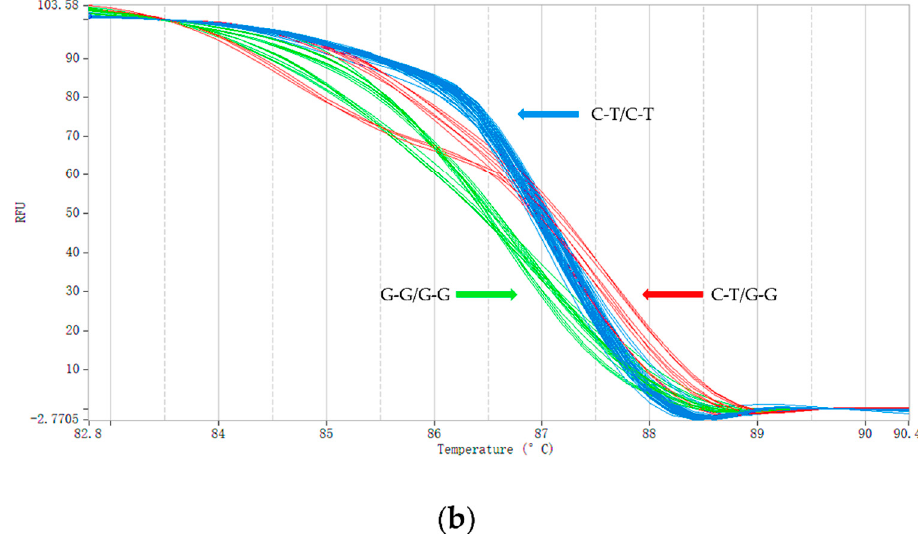
Figure 3. HRM genotyping results. ( a ) Typical shapes of the melting curves corresponding with the three genotypes (C-T/C-T, C-T/G-G, and G-G/G-G). The color of the curve is automatically assigned by PikoReal TM software. The vertical axis represents the change in fluorescence intensity and the abscissa represents the Tm value. The value of the abscissa corresponding with the main peak of each curve is the Tm value of the amplified fragment. ( b ) The melting curve image generated during the genotyping of Barag sheep and short-tailed sheep (a total of 32 samples are shown in the image; each sample was run in triplicate).